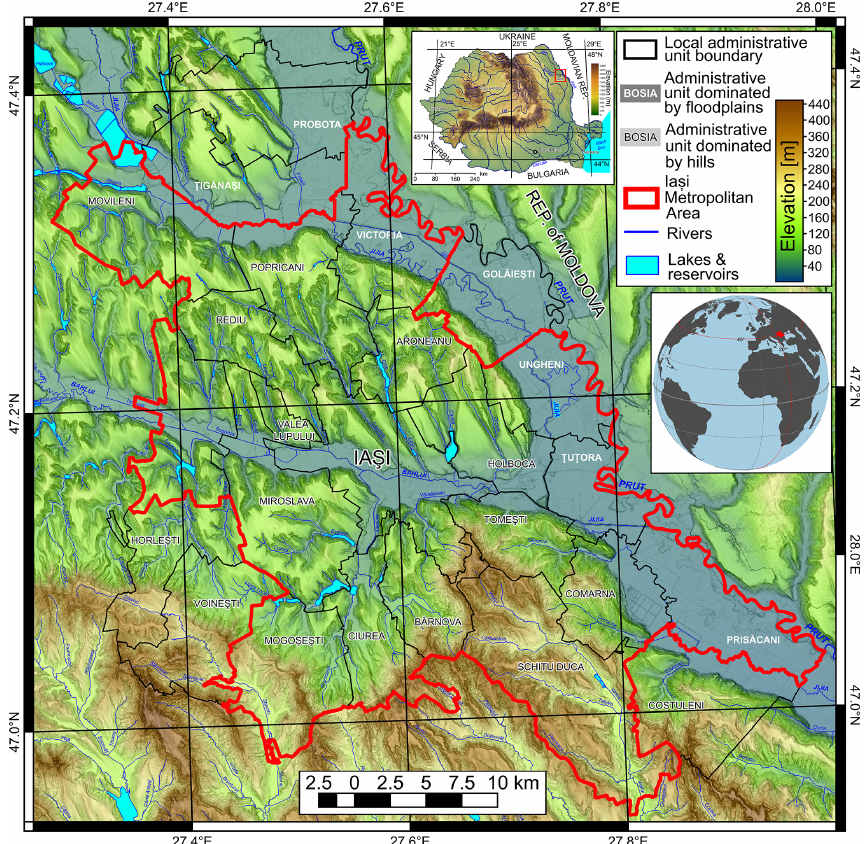
Figure 1. The geographical position of the study